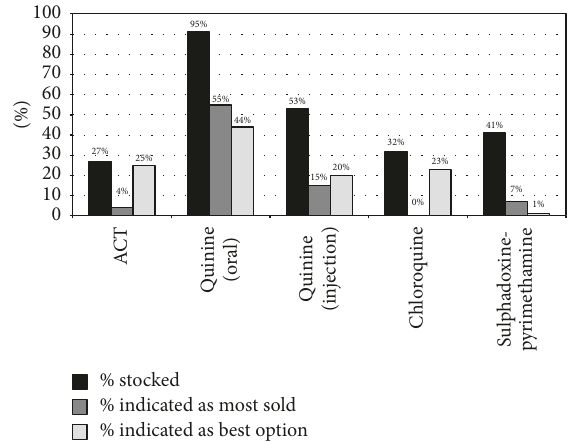
Figure 4: Contrasting vendors’ preferred antimalarials with what they stocked and sold the most of ( 𝑛 = 75 ). Drug vendors provided multiple